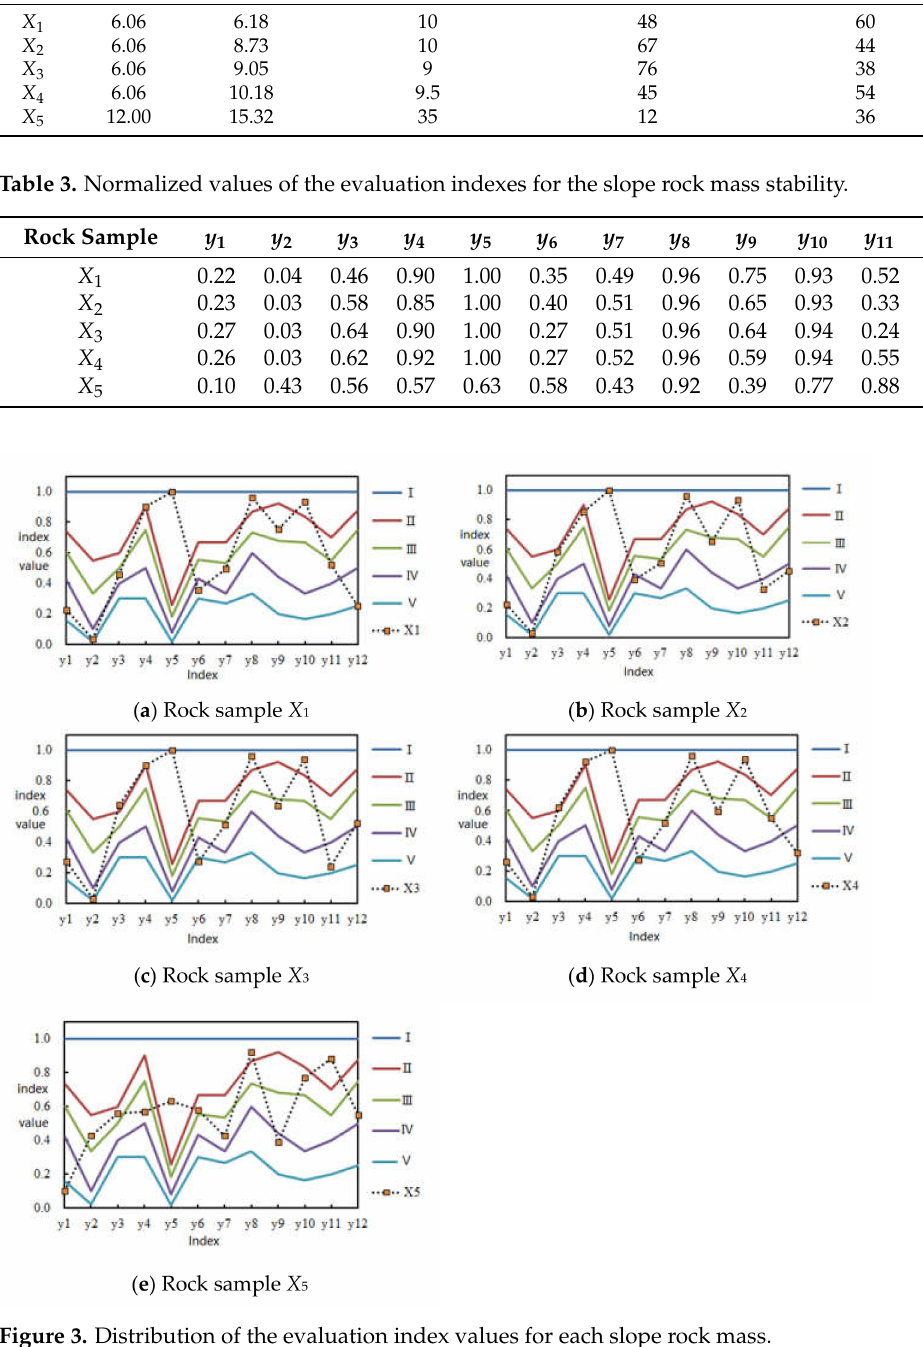
Figure 3. Distribution of the evaluation index values for each slope rock